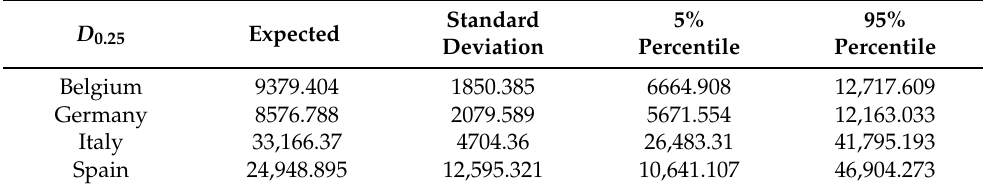
Table 11. Expectation, standard deviation and 5%–95% percentiles of simulated cumulated number of deaths, D t . 1000 simulations.